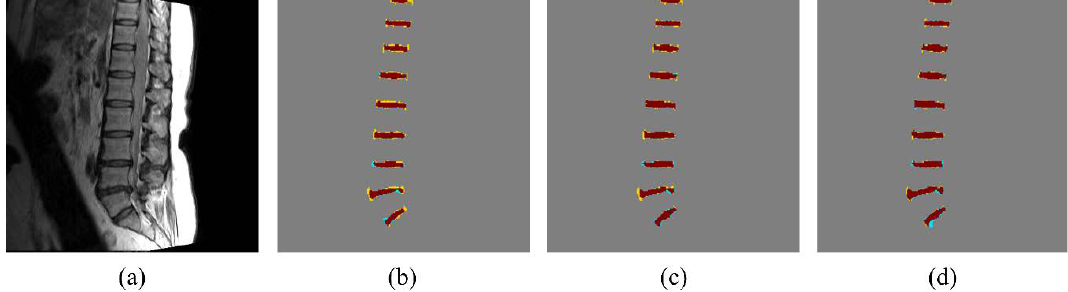
Figure 6. Segmentation result from networks. Brown area, yellow area, and blue area denote correctly segmented area, under-segmented area, and over segmented area, respectively. ( a ) Input image. ( b ) U-net result. ( c ) Dilated U-net result. ( d ) BSU-net result. Table 3. DSC and MHD measurements for five different networks including conventional U-net, BSU-net and three different networks applying several components of